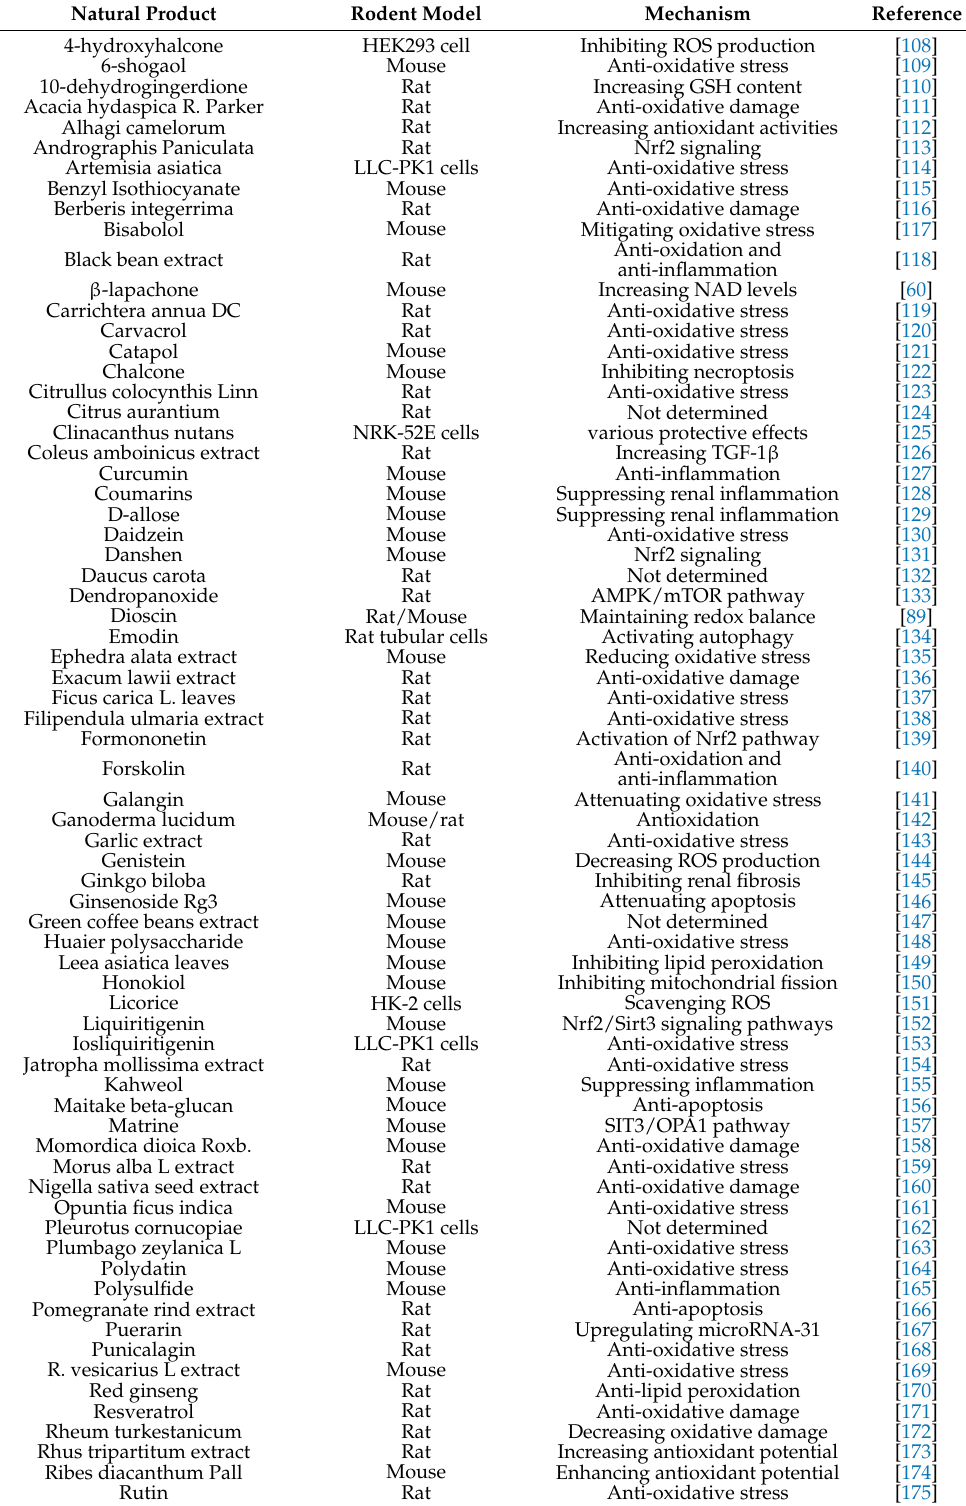
Table 1. Counteracting effects of plant-derived natural products on cisplatin- induced renal toxicity *. Natural